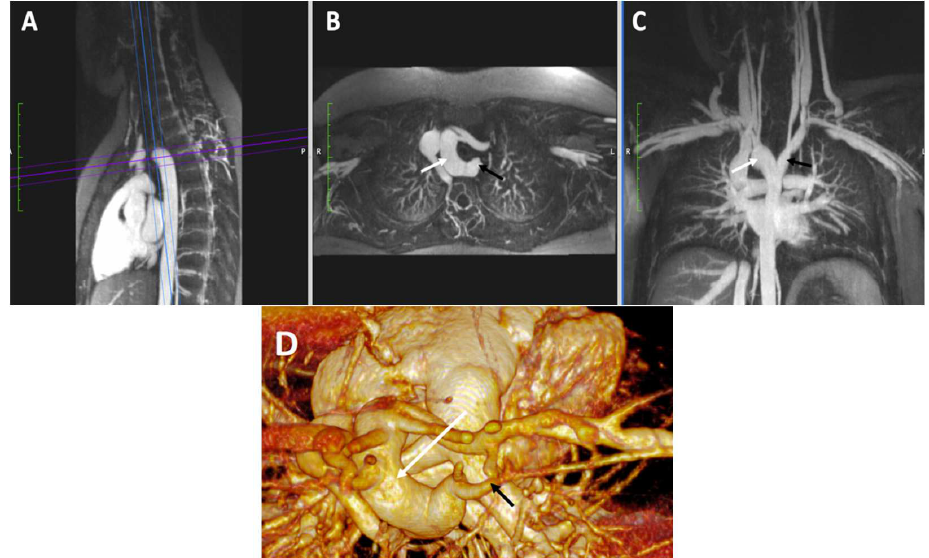
Figure 6. Vascular Ring. Reformatted maximum intensity projections from a breath-held FE-MRA study (Panels ( A – C )) and 3D volume rendering (Panel ( D )) depicting a right aortic arch (white arrows) with aberrant left subclavian artery (black arrows) arising from a diverticulum of Kommerell. This configuration forms a vascular ring causing mild tracheal compression in this patient.